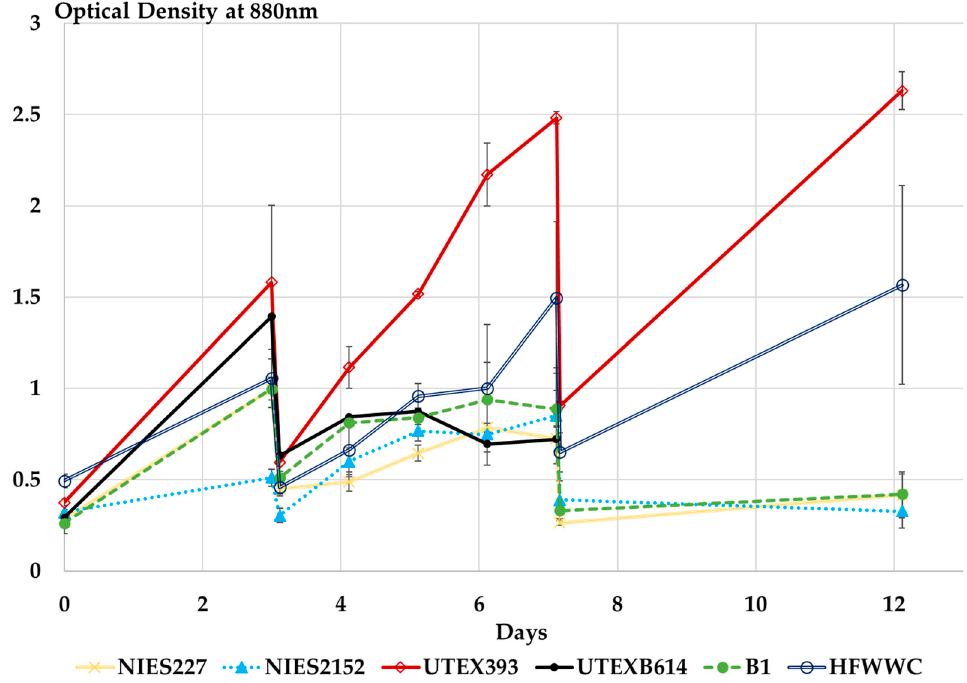
Figure 2. Evolution of the optical density (OD) at 880 nm for four strains (NIES227, NIES2152, UTEX393, and UTEXB614) and two consortia (B1 and hydroponic farm wastewater consortium (HFWWC)) grown in HFWW in a semi-continuous mode of 3, 4, and 5 days. Biomass productivities were high for NIES227, UTEX393, and UTEXB614 but it was significantly reduced in cycle 2 for all strains except for UTEX393 and HFWWC (Figure 3). UTEXB614 was removed from the test after cycle 2 since the culture was not healthy. Despite having a high final OD, UTEX393 productivity decreased also in cycle 3 since the ratio DCW/OD decreased on day 12. The decrease of the growth rate might be due to a lack of some nutrients in HFWW (micronutrients or phosphate if precipitated). On the contrary, inhibition could have been caused by, high level of nutrients (phosphate if not precipitated). The best candidates for HFWW bioremediation were found to be UTEX393 and HFWWC. These strains might be more resistant to the variations in nutrients availability. Biomass production rates were 0.193 g/L/d for UTEX393 and 0.252 g/L/d for HFWWC on average. The evolution of the nitrate, phosphate and sulfate concentrations are available in Appendix B. Average nitrate reduction rates were 23.5 mgN/L/d for UTEX393 and 21.9 mgN/L/d for HFWWC.